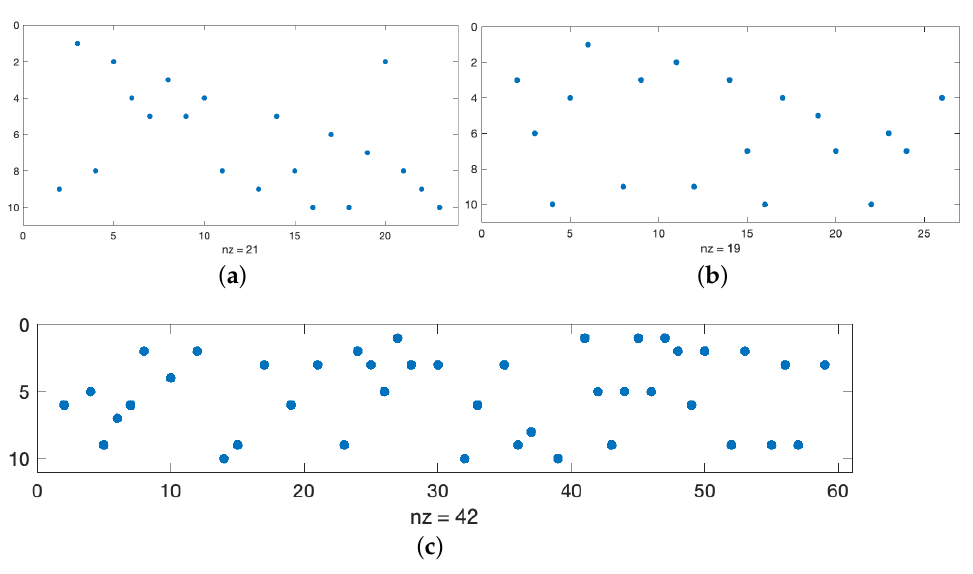
Figure 5. A dot-plot of the strings: ( a ) !5511DAAB3223BBD!53DECCE44ADD55E, member of the Healthy class; ( b ) !!!2CEB1!52!AA55!!24EBBB!!!334!ECC4!B, member of the Chronic class; ( c ) !!!C!3354CCAA!B!A!!E5!!!2!!C!2!5A23122!2!EC!25D!EEE!1353131ACCA!5A!525!2!, member of the Extrapyramidal